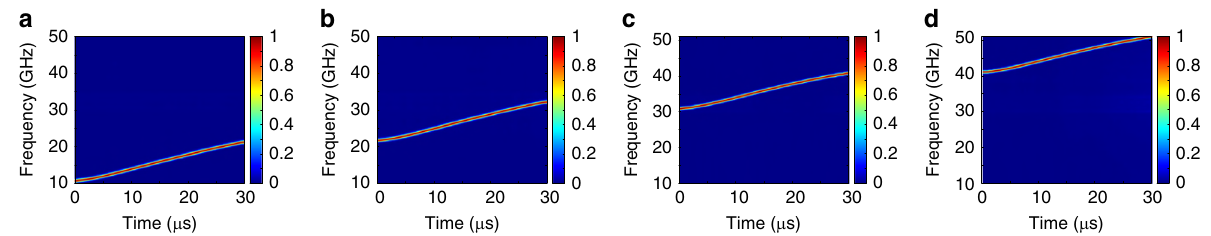
Fig. 6 Center frequency tuning of the generated LCMW. a 16.0 GHz, b 26.6 GHz, c 37.0 GHz, and d 45.5 GHz. During tuning the pulse bandwidth and pulse duration are maintained to be 10 GHz and 30 µ s.